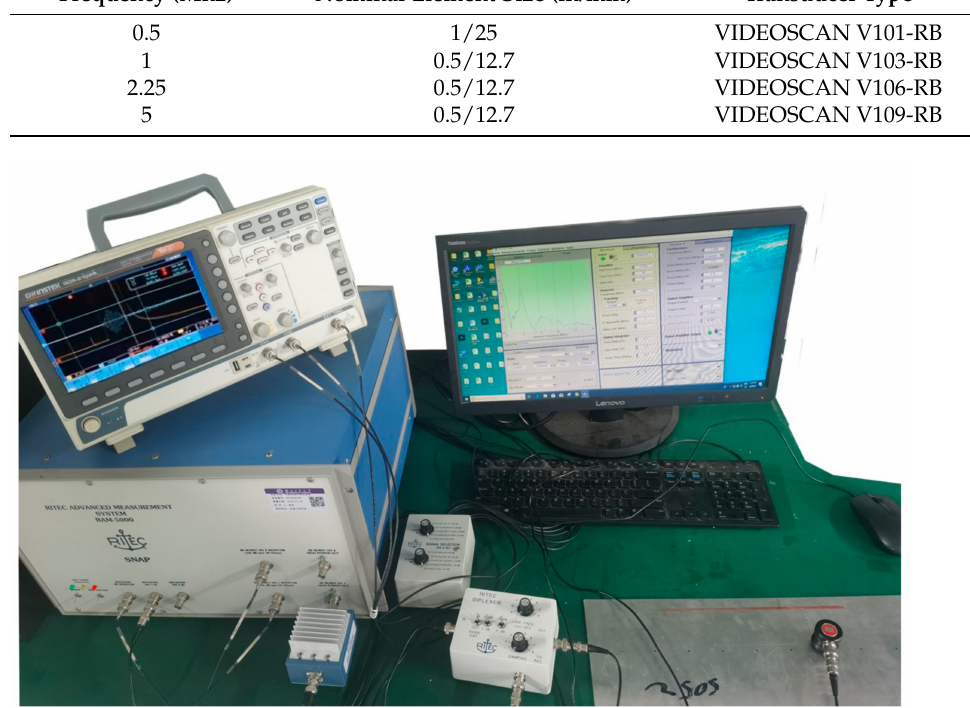
Figure 2. The schematic diagram of experimental